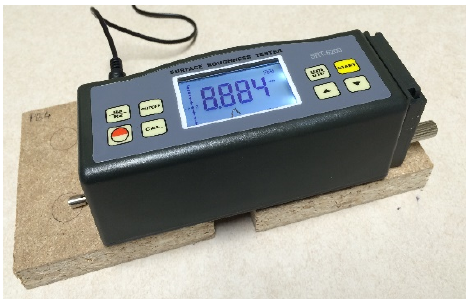
Figure 1. Roughness tester of SRT 6200 type.